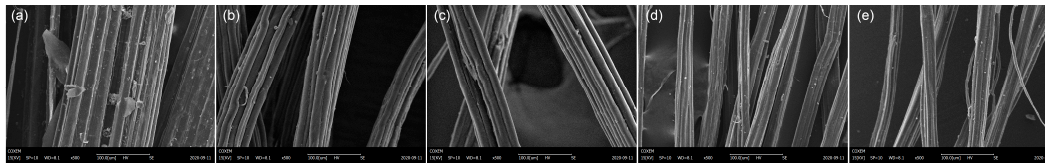
Figure 8. SEM images of ( a ) raw jute fibers, jute fibers pretreated at 100 °C for ( b ) 3 and ( c ) 5 h, and jute fibers pretreated at 130 °C for ( d ) 3 and ( e ) 5 h.